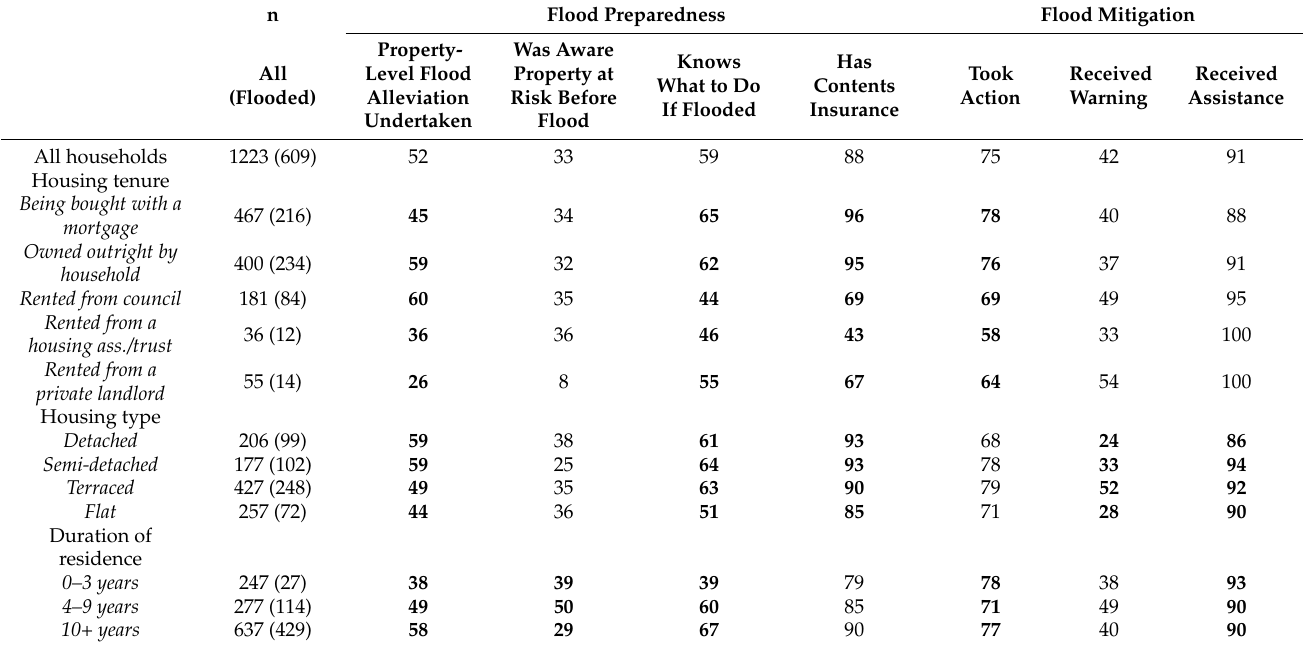
Table 3. Flood resilience by housing and residential characteristics. (% of